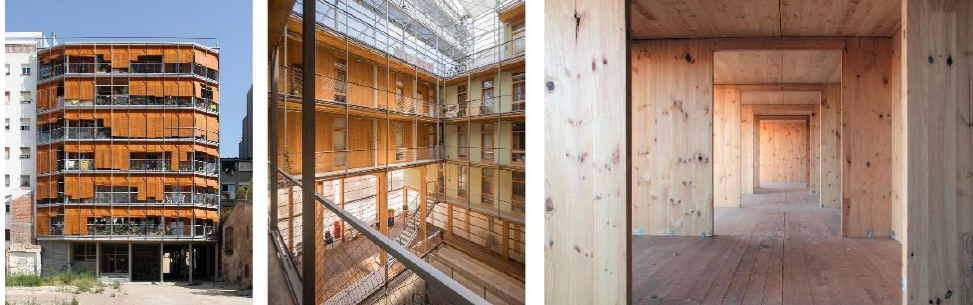
Figure 5. Left: La Borda, housing elevation as seen from Can Batlló. Centre: The courtyard in La Borda forming a central void in the building that connects different uses: bike store (ground floor), large meeting room (1st floor), guest rooms (at the back), dwellings (to the left with a timber facade) and the “greenhouse” rooftop. Right: La Borda under construction. Promenade between dwellings, later enclosed and adapted by the dwellers using “temporary” partitions. Source: Courtesy Lacol (left and right); and Lacol and Lluc Miralles (centre).